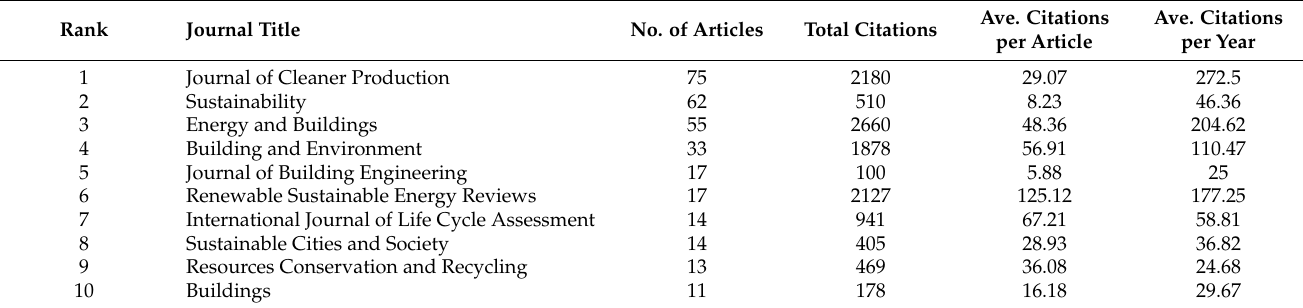
Table 1. Top research journal sources in 2000–2022.